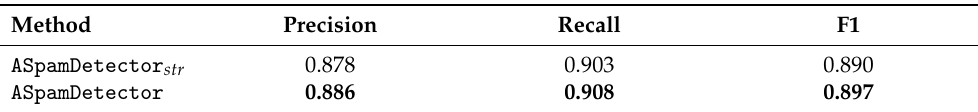
Table 7. Validating the importance of the concatenation of the learned content-based and structure- based user